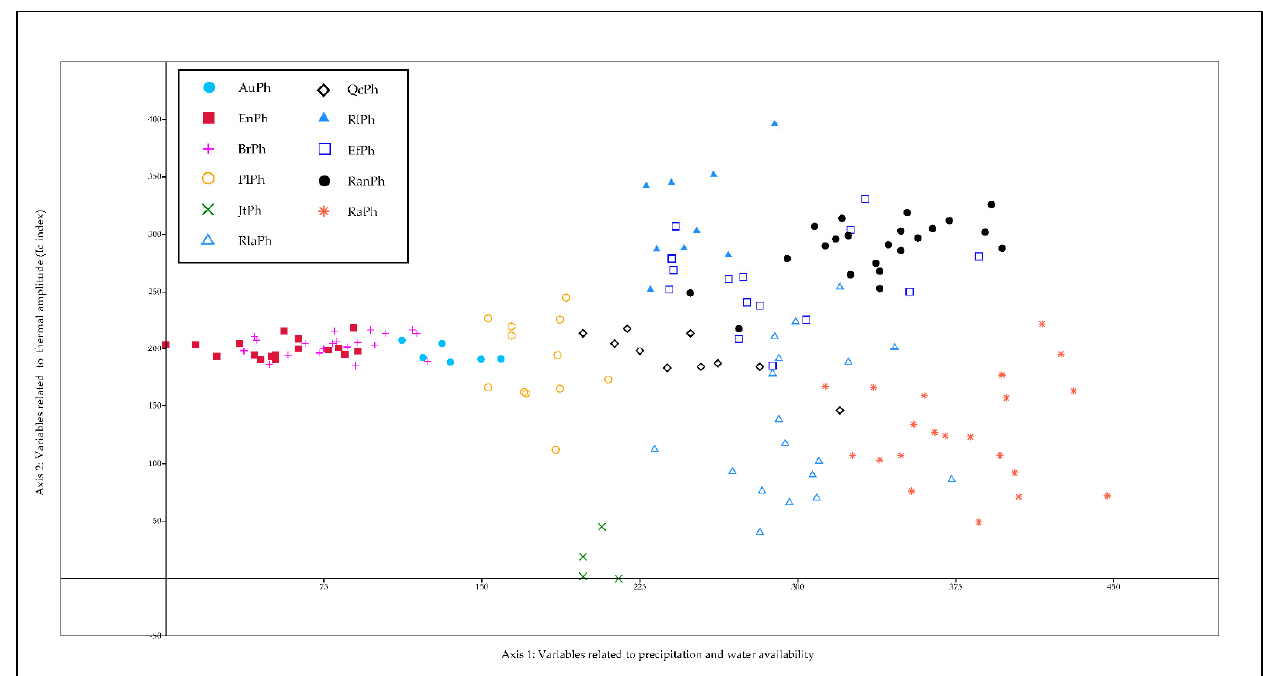
Figure 2. DCA analysis of Pinus halepensis Mill. communities on the Iberian Peninsula. Table 2. Analysis of means by Kruskal-Wallis test of the selected bioclimatic variables associated with each sampling point.